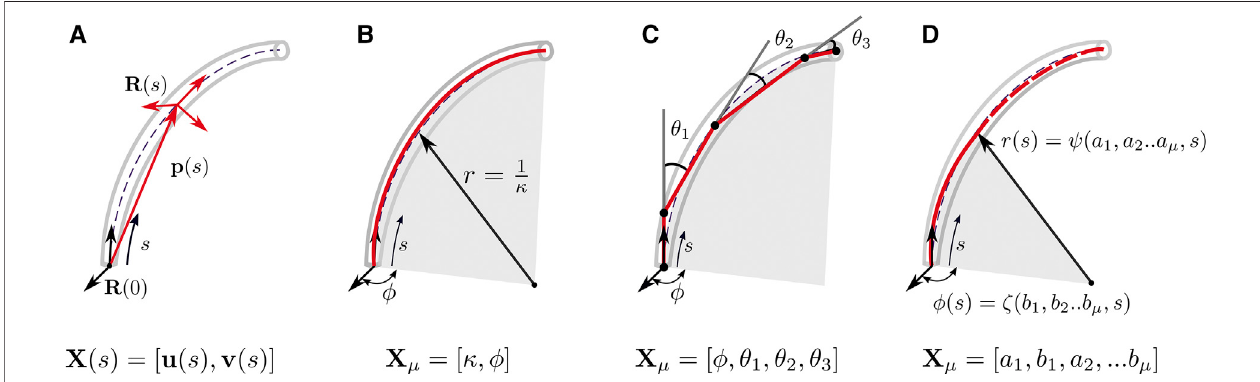
FIGURE 5 | Diagrammatic representation of various kinematic frameworks used to describe the backbone. The backbone parameters required are denoted by X ( s ) for distributed backbone parameterization and X μ for lumped backbone parameterization. (A) Variable curvature representation use to describe the position p (s) using an attached frame, whose orientation is represented by R ( s ) (B) Arc parameters ( κ , ϕ ) used to describe a segment with constant curvature without torsion (C) Pseudo-rigid body 3 R model approximating the backbone as a four link serial manipulator (D) Representing the backbone parameters using shape functions ψ ( a , a ,.. s ) and η ( b , b .. s ) in the modal 1 2 1 2